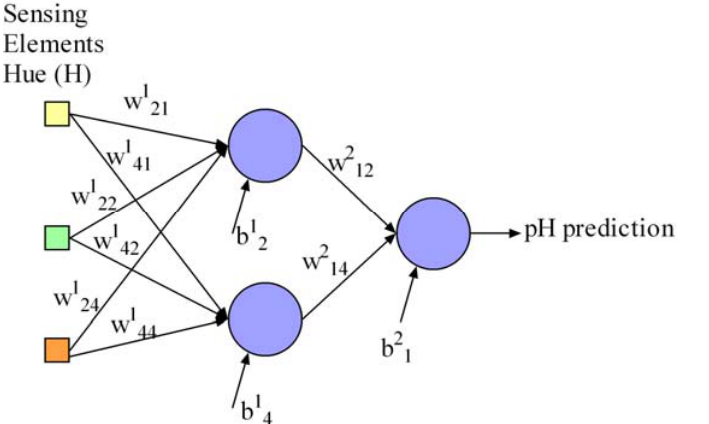
Figure 3. Example of the neural network described in Equations